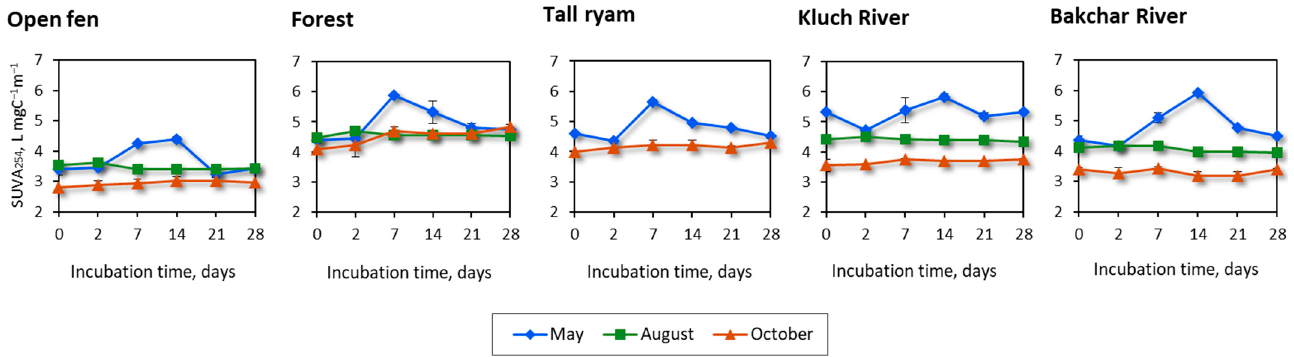
Figure 5. SUVA 254 (L mg C − 1 m − 1 ) along the aquatic continuum by season during incubation time. The error bars are ±1 SD of the triplicates unless within the symbol size.